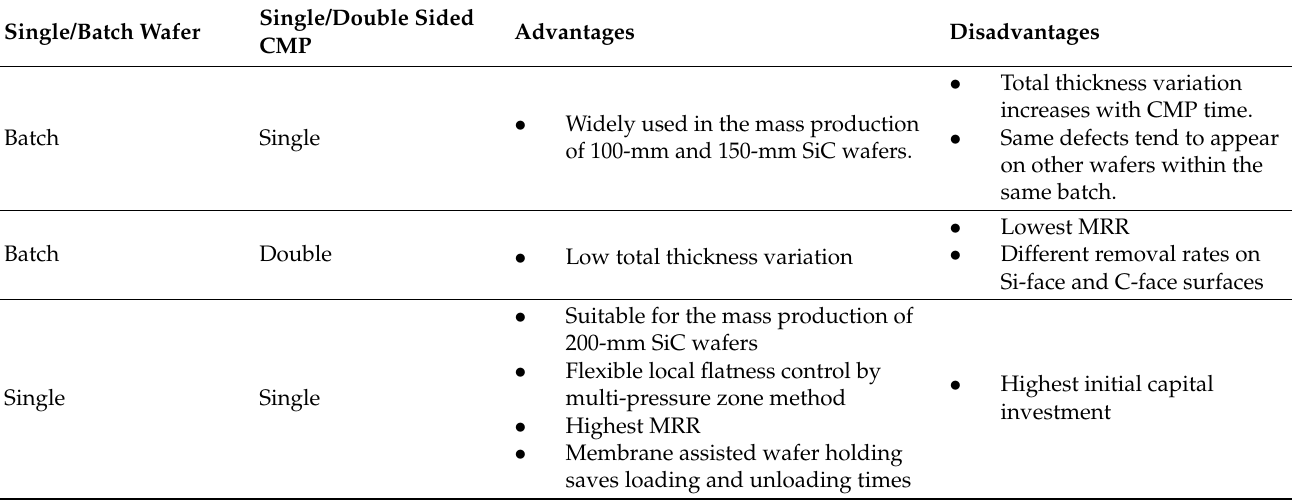
Figure 2. Different configurations of SiC CMP, including ( A ) batch wafer and single-sided CMP, ( B ) batch water and double-sided CMP and ( C ) single wafer and single-sided CMP. (Ref. CMC Materials Co.). Table 2. Comparison between different configurations of SiC CMP. (Ref. CMC Materials Co.).